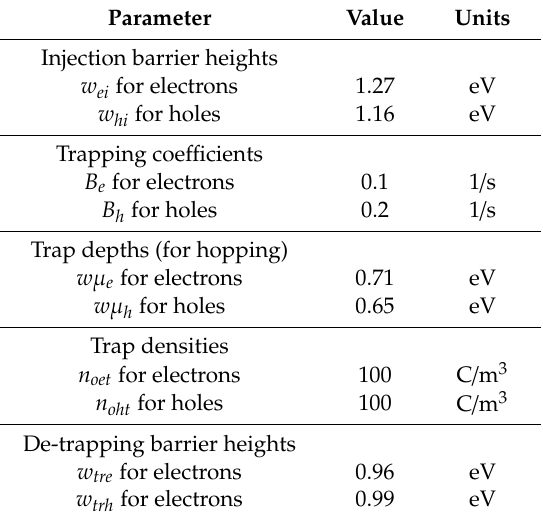
Figure 2. Schematic representation of the cable geometry ( a ), and the one-dimensional grid used for the simulation ( b ). Table 1. Parameters used for the